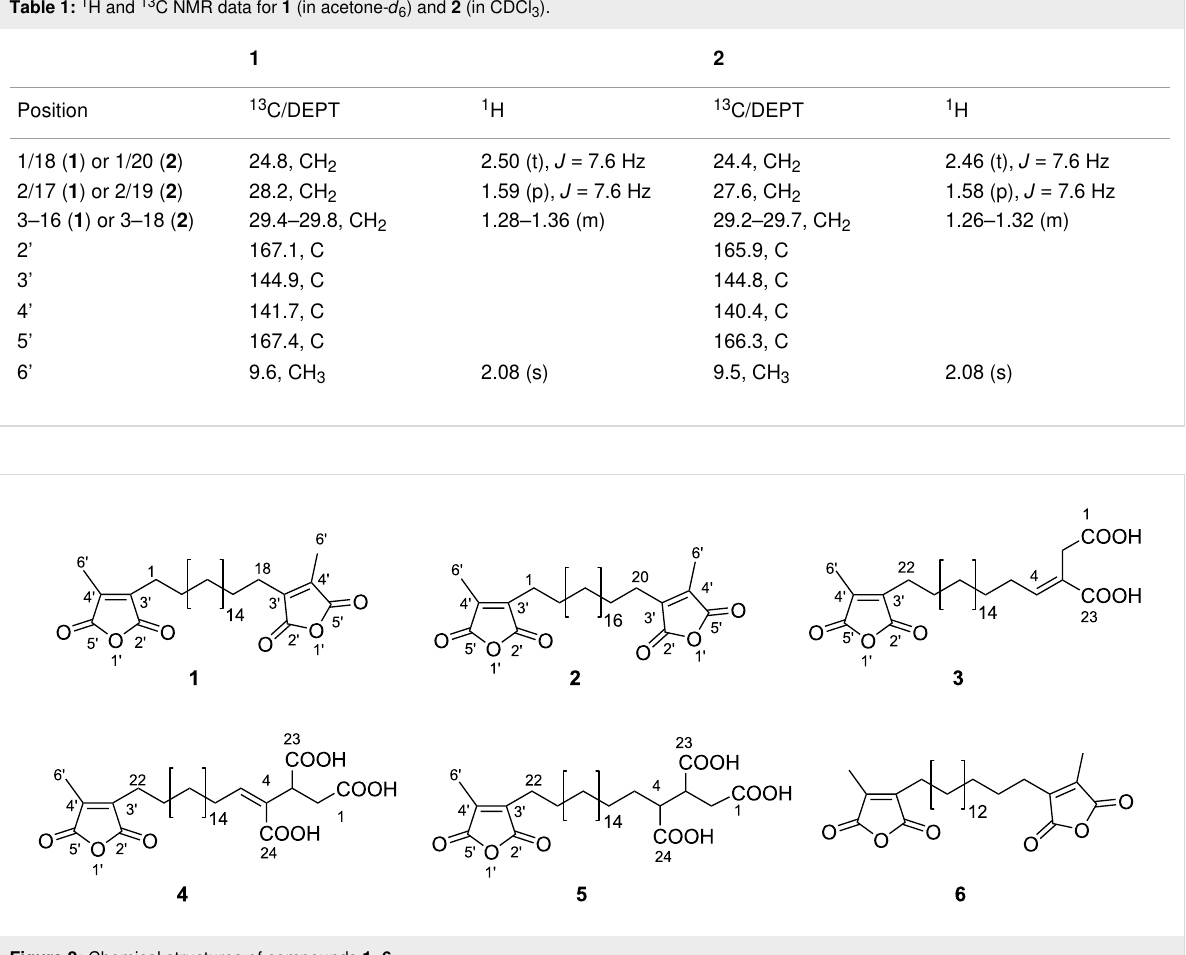
Figure 2: Chemical structures of compounds 1 – 6